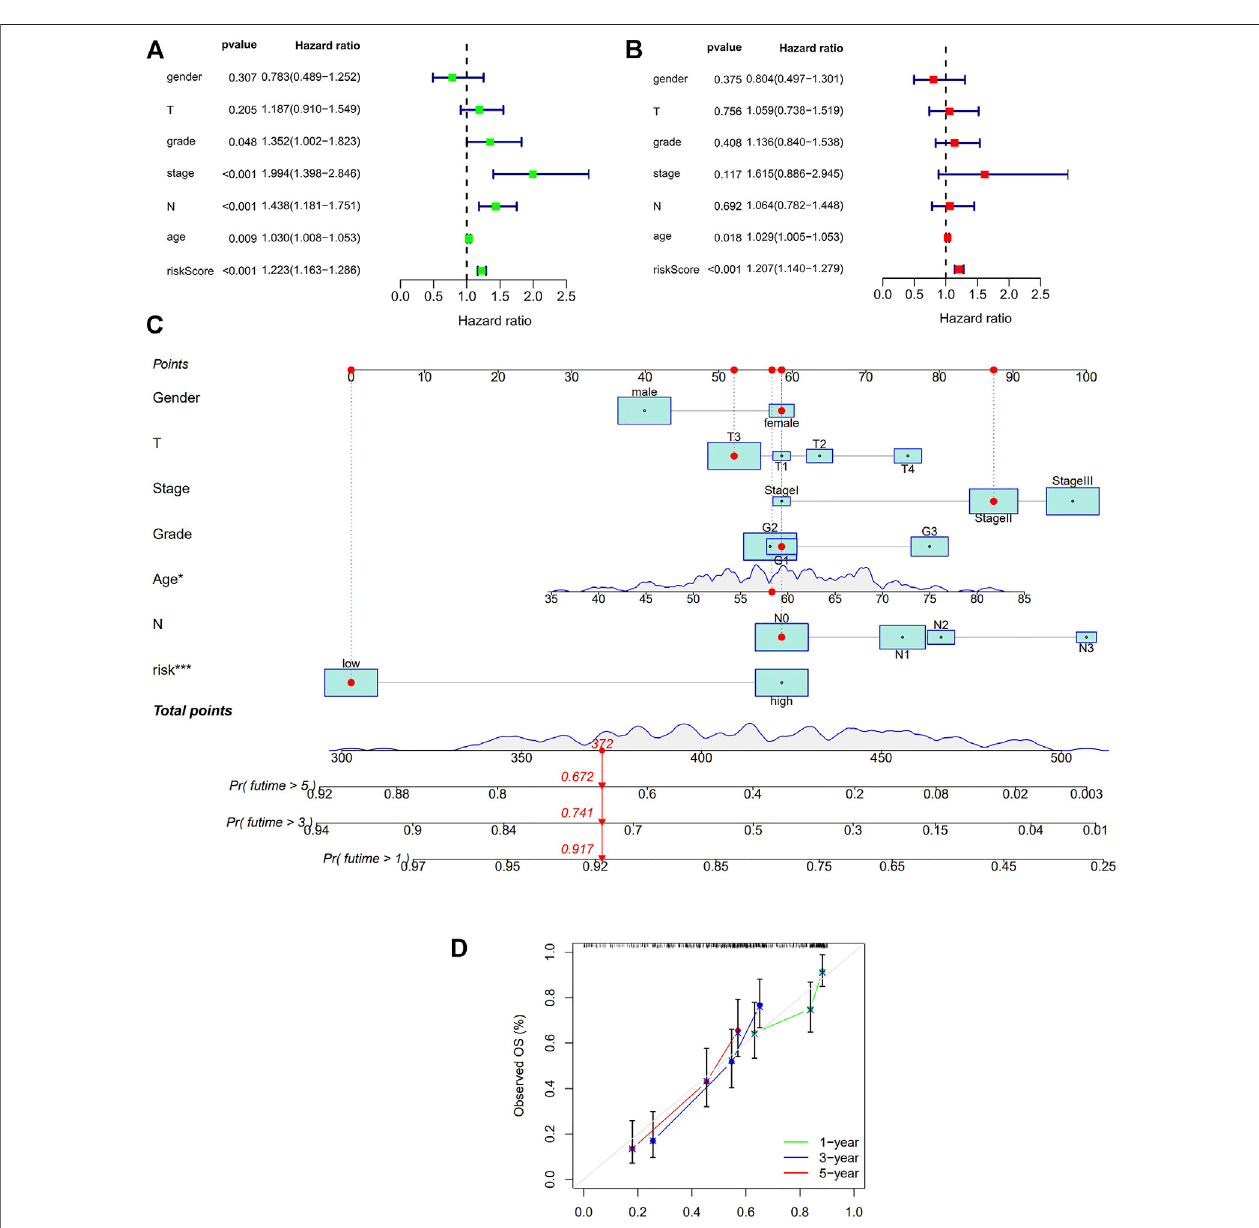
FIGURE 5 | Cox regression analysis and Nomogram in the training set. (A) : Univariate Cox regression of risk model and other clinical factors in the training set (B) : Multivariate Cox regression of risk model and other clinical factors in the training set (C) : Nomogram for both clinic-pathological factors and prognostic autohphagy- related lncRNAs. The value of each variable corresponds to a score on the point scale axis. A total point can be calculated by adding all scores according to each patient ’ s situation and projected to the risk scale. (D) : Calibration curves for the nomogram. The x-axis represents the nomogram predicted OS and y-axis represents observed OS in reality. Perfect prediction would correspond to the 45-degree gray